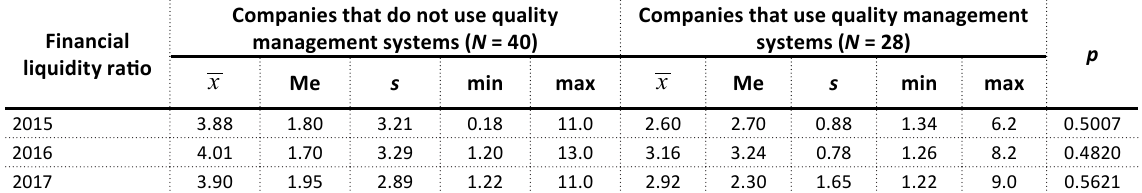
Table 4. Average results for the financial liquidity ratio in the analyzed